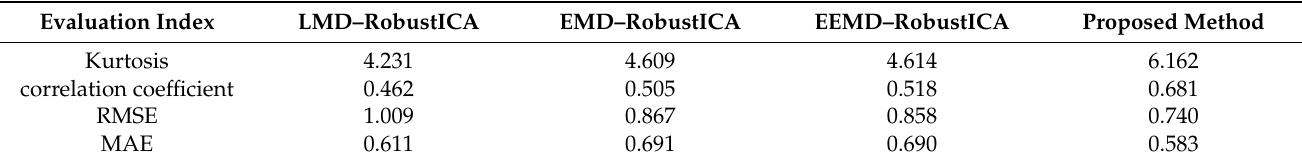
Table 5. Comparison of noise-reduction effect index